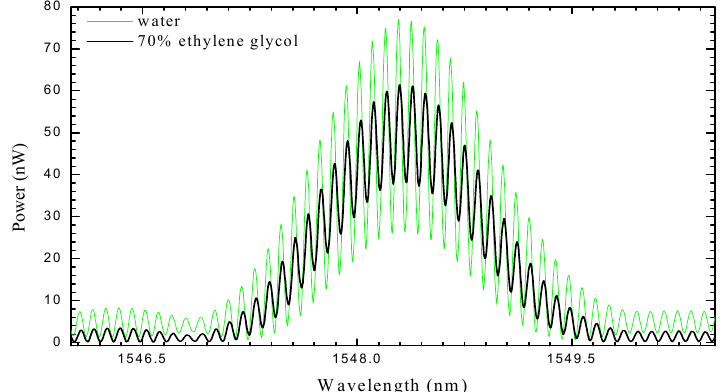
Figure 2. Channeled spectra of the Fabry-Perot cavity, showing the changes in fringe visibility when going from water to a solution of 70% ethylene